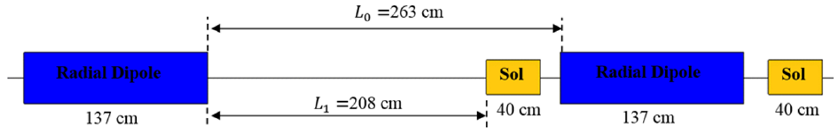
Figure 3. Placement of weak control solenoids among structural radial dipoles